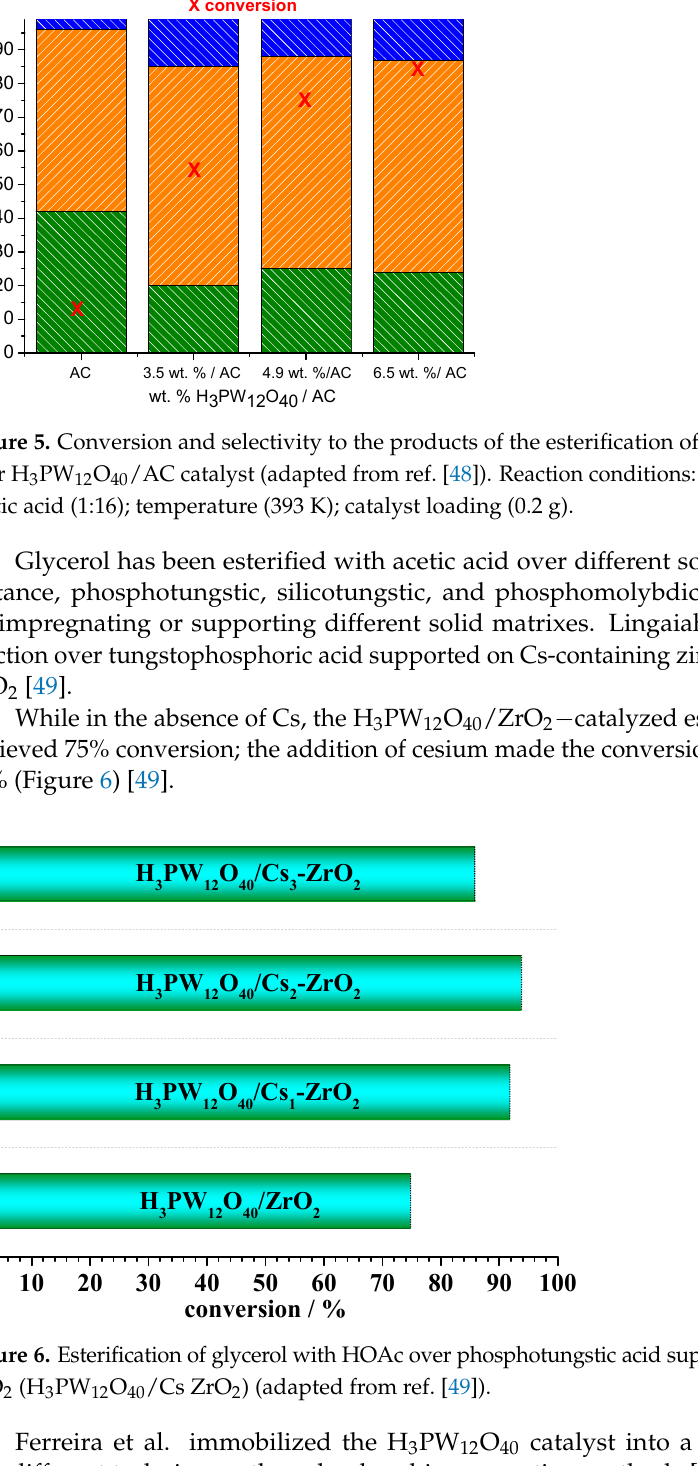
Ferreira et al. immobilized the H 3 PW 12 O 40 catalyst into a silica matrix through two different techniques: the sol-gel and impregnation methods [50]. Those authors as-